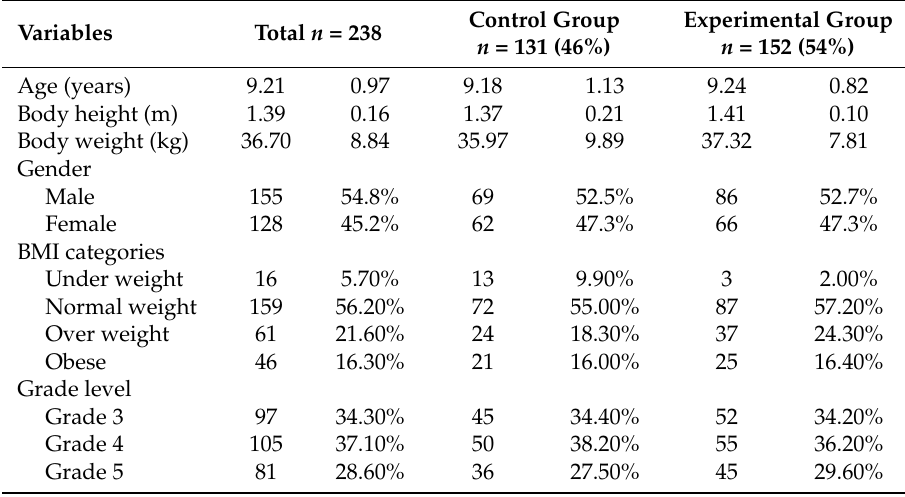
General characteristics (mean, standard deviation and frequency) of the sample of the